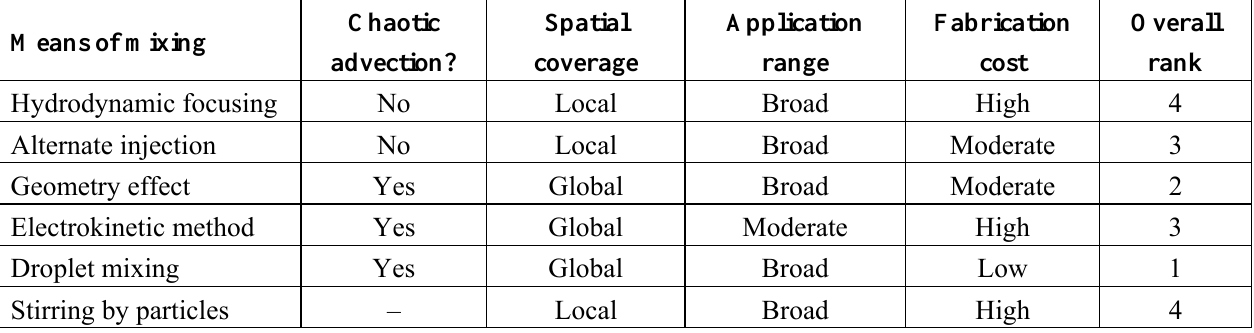
Table 1. Summary of the main features of various means for micromixing and their overall rank for use in microfluidic devices as a